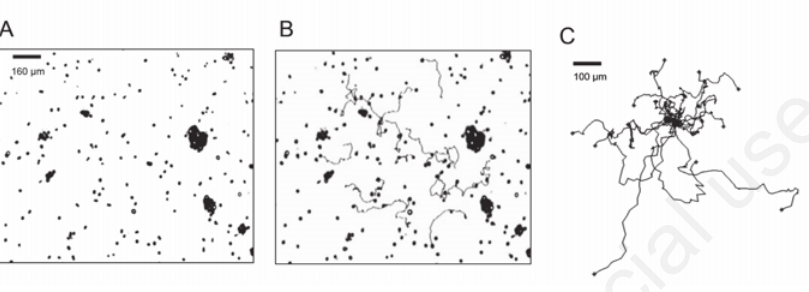
Figure 1. Mytilus edulis hemocyte tracking by time lapse imaging of Hoechst 33342- stained nuclei. A) 500 µL of freshly withdrawn hemolymph were plated on glass bottom 35-mm dishes and covered with 2 mL marine physiological saline solution. Nuclei were stained with Hoechst 33342. Last wide field epifluorescence inverted micrograph from a 30-min 0.033-Hz time-lapse sequence under x10 magnification used to track nuclei (HBO arc lamp, excitation 377/50 nm, emission 409 nm). B) Twenty hemocyte tracks computed from nuclei in motion for 30 min in the microscopic field and distinct from aggregates are superimposed to the image shown in A. C) Overlay of twenty hemocyte trajectories displayed from a common origin. The point reached by each cell after 30 min recording is indicated by a small cross.